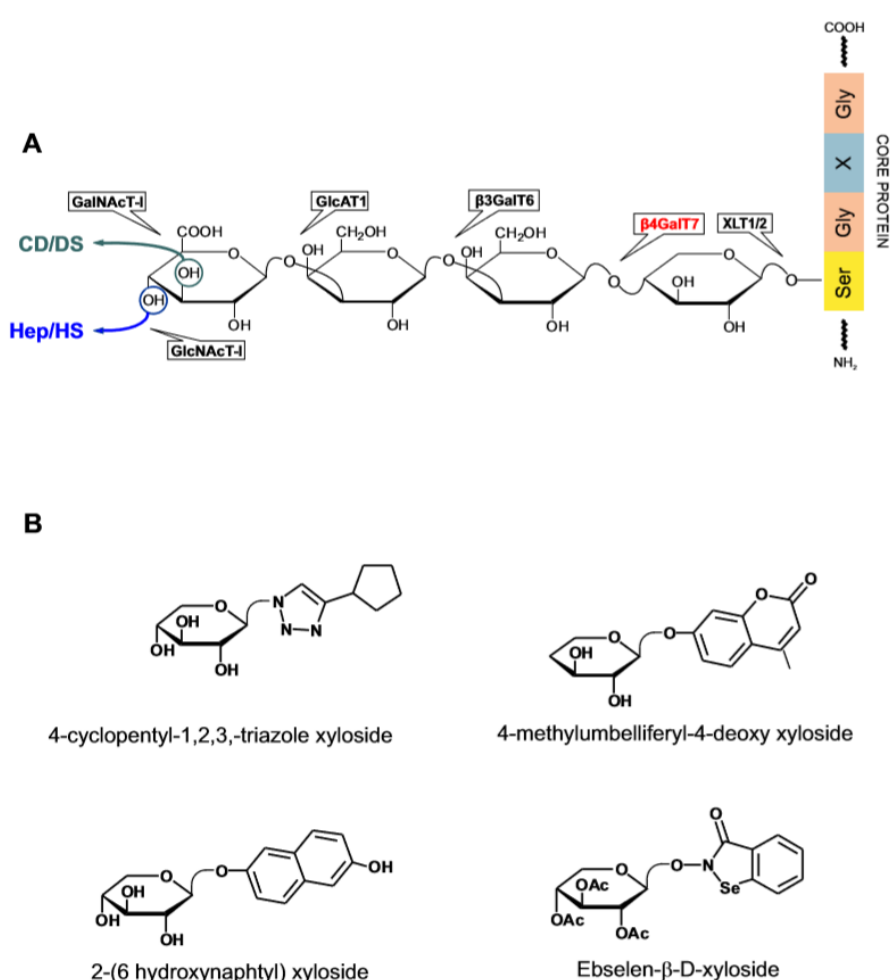
Figure 5. Biosynthesis of the glucosaminoglycans and galactosaminoglycans (GAGs) protein linker tetrasaccharide and recently investigated xylosides. ( A ) Catalytic steps and site of action of β4GalT7. ( B ) Xylosides as Xyl decoy substrates and enzymatic inhibitors of β ( B ) Xylosides as Xyl decoy substrates and enzymatic inhibitors of β4GalT7.